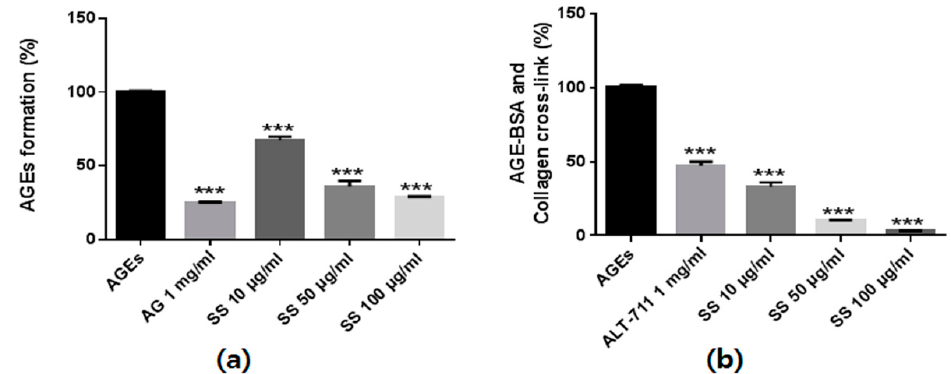
Figure 2. The anti-glucotoxicity effect of Spatholobus suberectus . ( a ) The inhibitory effects of S. suberectus extract on in vitro AGEs formation. Bovine serum albumin (5 mg/mL) was incubated with 25 mM glucose and fructose in the presence or absence of S . suberectus in phosphate-buffered saline for 14 days. ( b ) The ability of S . suberectus to break AGEs cross-linking. The optical density of AGEs-collagen cross-linking was determined using tetramethylbenzidine as the substrate. Aminoguanidine (AG) and alagebrium (ALT-711) were used for positive control of AGEs formation and AGEs cross-linking assay. Each experiment is performed three independent experiments for three repeat experiment, and data are presented as the mean ± standard deviation (SD, %) values (* p < 0.05 and *** p < 0.001 vs. AGEs).